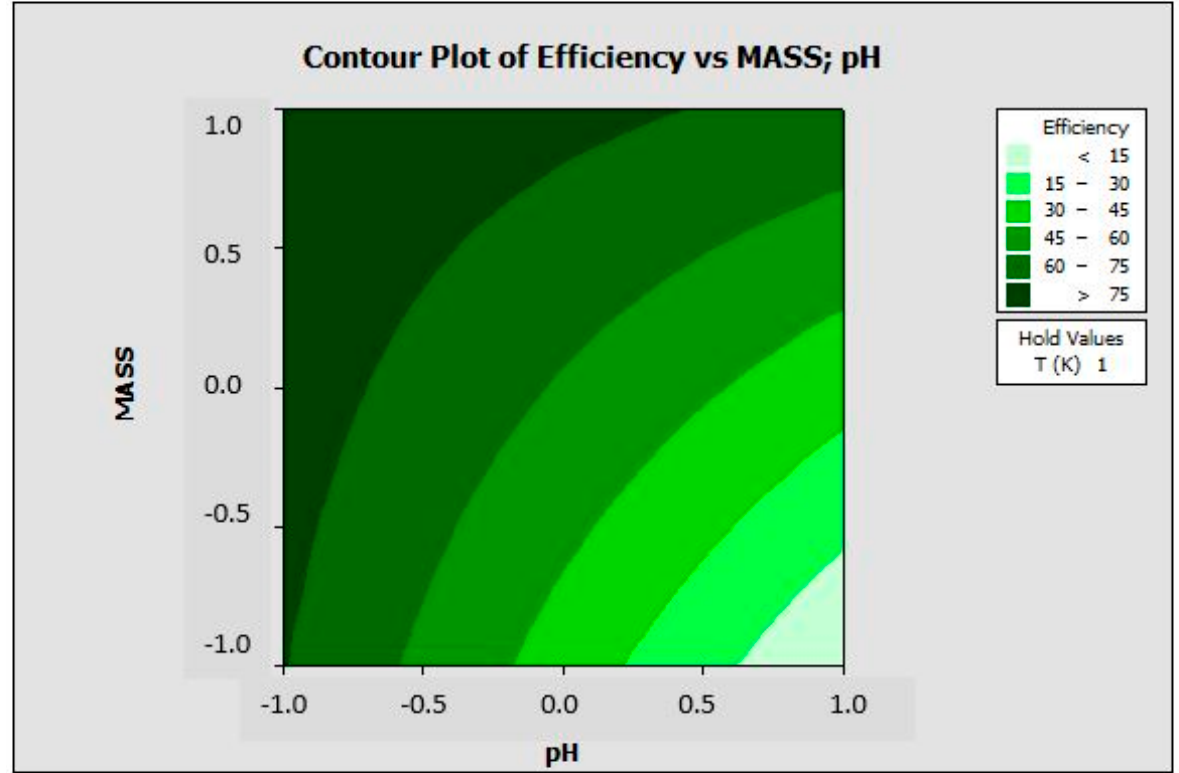
Figure 10. Effects of mutual interactions among factors on BR dye removal efficiency.